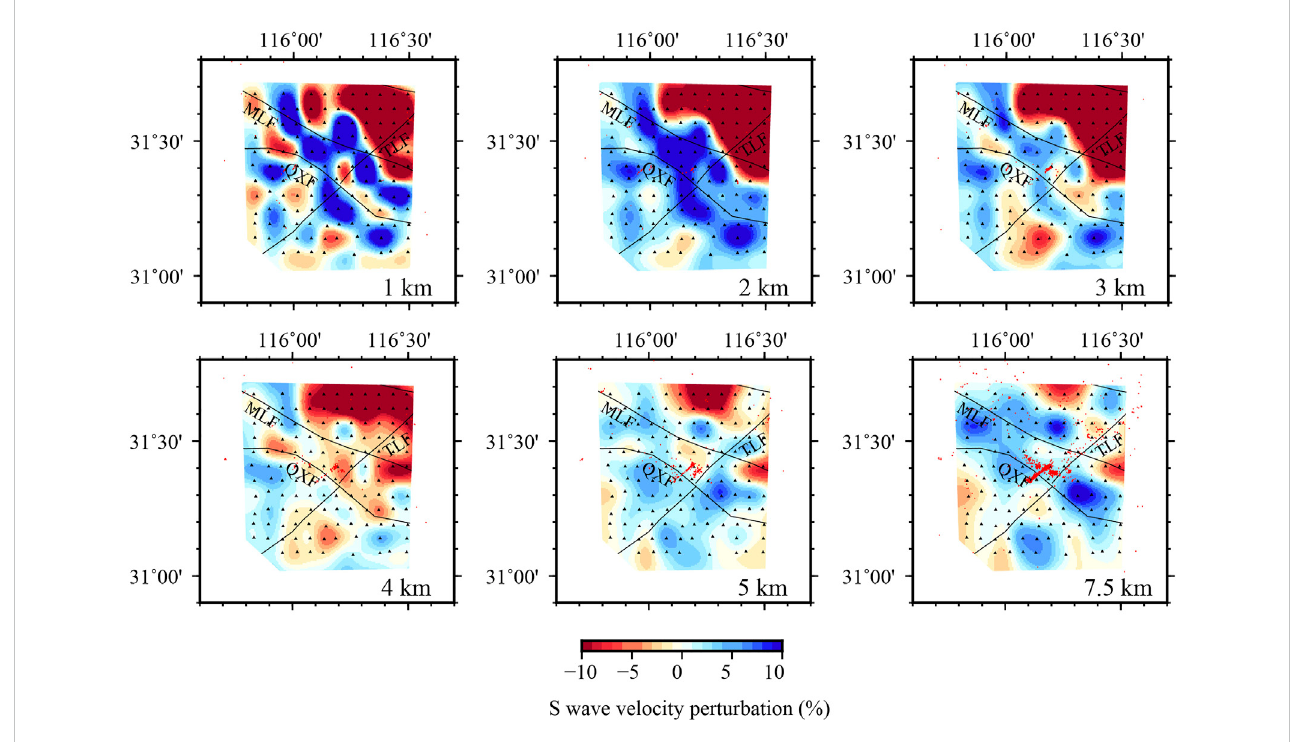
FIGURE 8 Slices of shear wave velocity at the depths of 1 – 7.5 km (Red dot represents the re-locations of earthquakes below magnitude